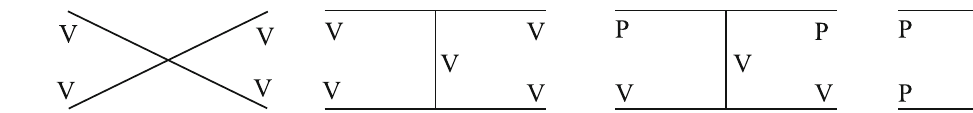
Fig. 1 Kinds of diagrams needed for the tree level